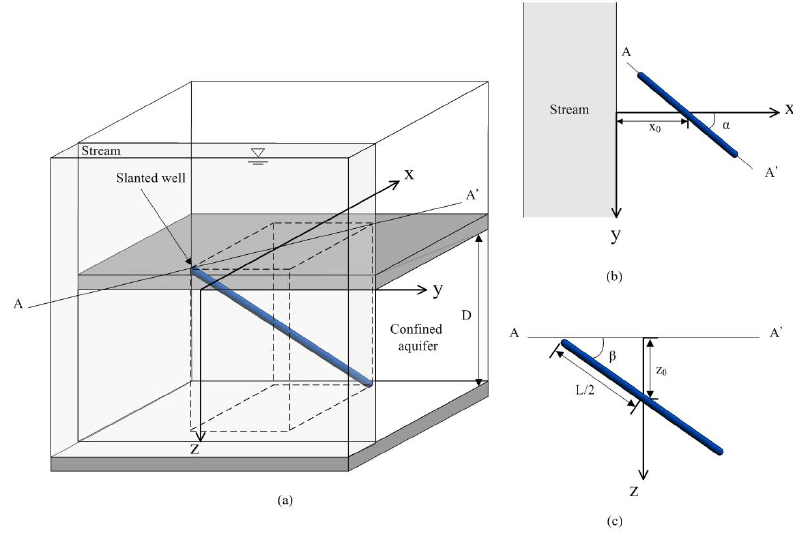
Fig. 1. Schematic diagram. (a) 3-D view (b) top view (c) view of vertical plane including cross section A-A’